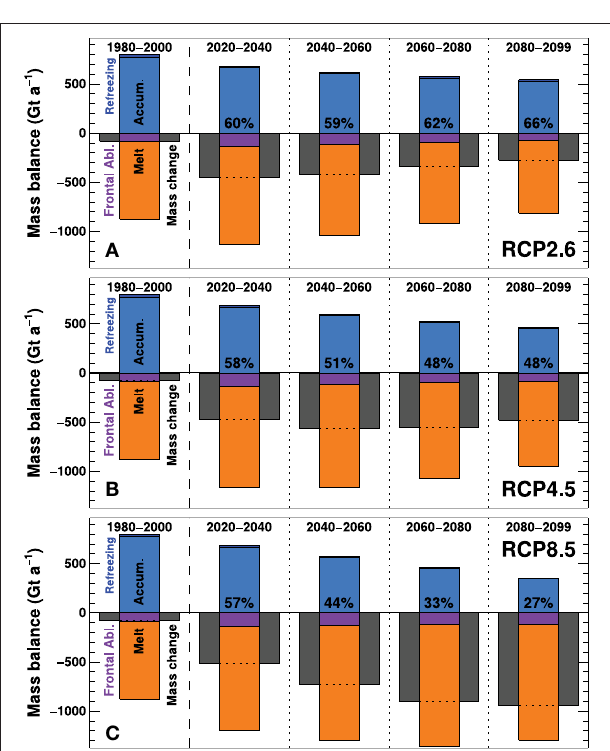
FIGURE 10 | Modeled components of the global glacier mass budget for (A) RCP2.6, (B) RCP4.5, and (C) RCP8.5. Bars show 20-year averages of accumulation, refreezing, melt, frontal ablation, and mass change rates (dark gray). Future periods show multi-model means of all GCMs. Percentages refer to the fraction of ablation that is compensated by mass